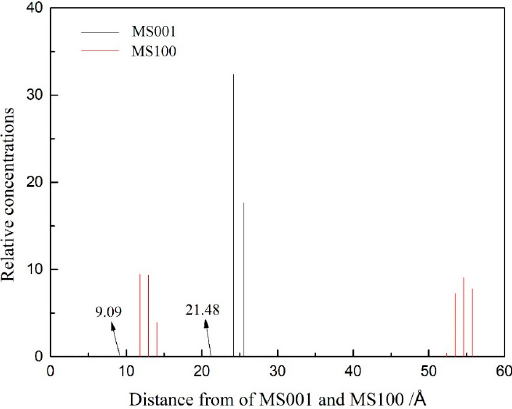
Figure 5. The relative concentration of SCA on the MS001/MS100. The distance of 21.48 Å/9.09 Å are the locations of the MS001/MS100, respectively.